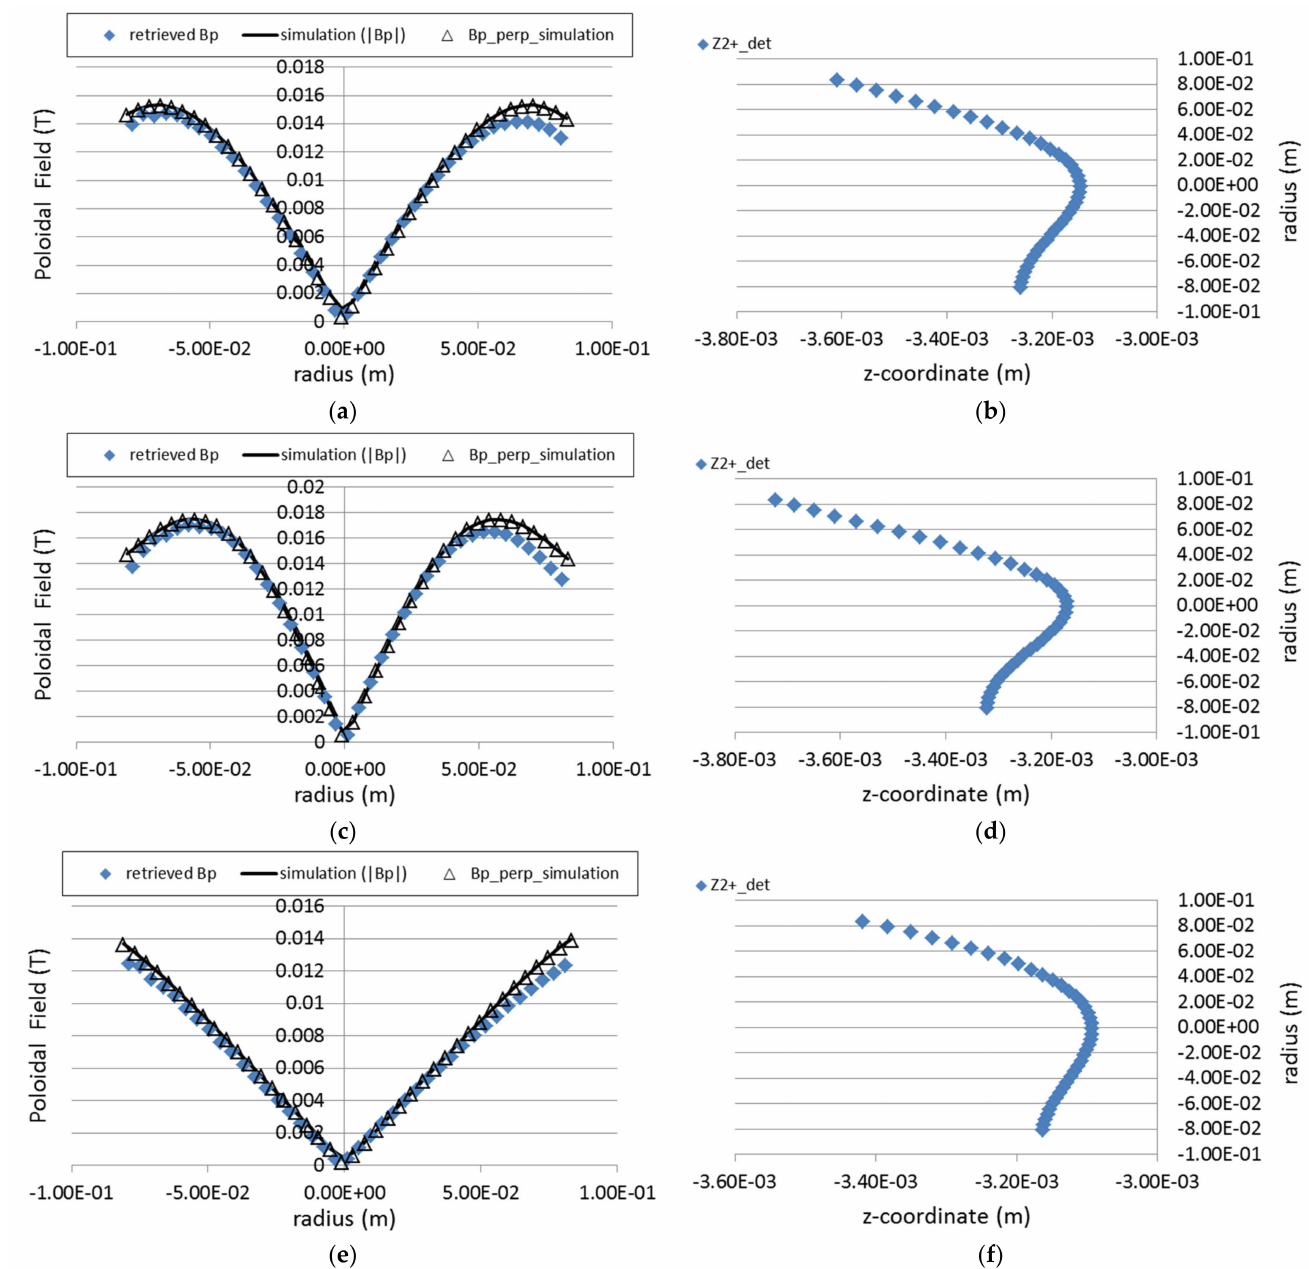
Figure 18. On the left side, figures show the retrieved values of the poloidal field profile (solid triangles) for three different current density profiles: ( a ) parabolic, ( c ) peaked (parabola square) and ( e ) flat. The values of the inputted profiles of the total poloidal filed and of the B p z-component are also displayed in the same graph. The figures on the right ( b – f ) show the corresponding detector z-positions of the secondary beams as a function of the radial location of the ionization